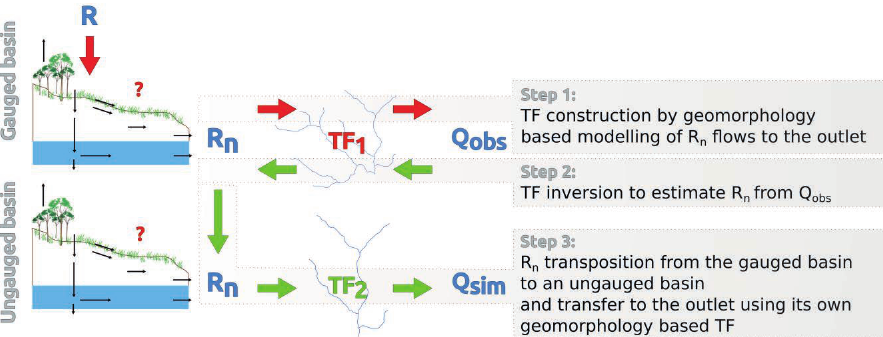
Fig. 2 Methodology of hydrograph transposition (from de Lavenne et al.